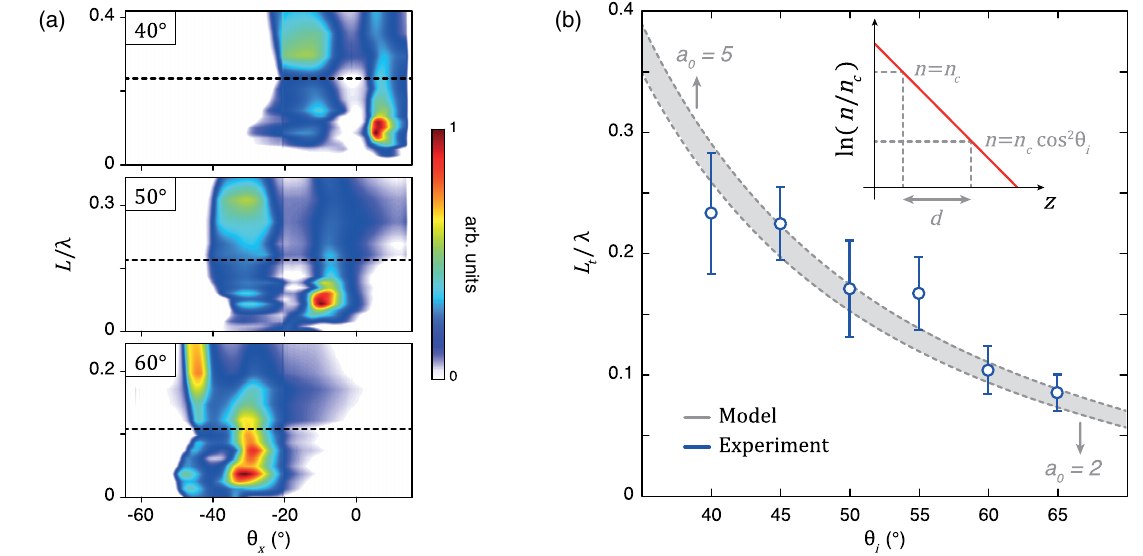
FIG. 12. Effect of the laser incidence angle on the laser-plasma coupling. Panel (a) shows the evolutions with L of the high-energy electron beam angular profile in the incidence plane, measured for three different incidence angles, for a laser field amplitude a 0 ≈ 3 . 5 . For each angle, L is measured experimentally using the SDI technique. The value L e t where a transition occurs is clearly observed to decrease with θ i . The measured evolution of L e t with θ i is plotted in (b), where it is compared to the simple model described in the text. The predictions of this model are shown for a range of laser amplitudes 2 ≤ a 0 ≤ 5 , to account for the experimental uncertainty on this amplitude. These predictions are very close to the high-amplitude limit given by Eq.